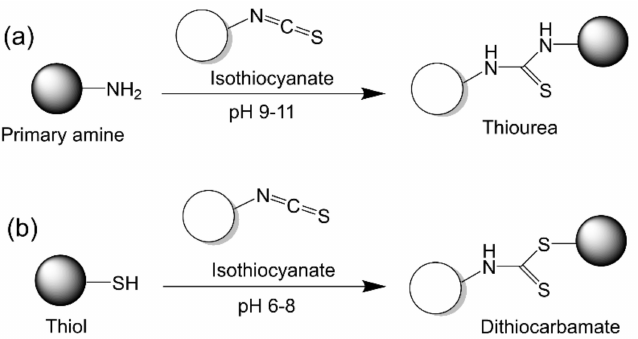
Figure 11. Isothiocyanate chemistry. ( a ) Isothiocyanate reacting with primary amine. ( b ) Isothio- cyanate reacting with